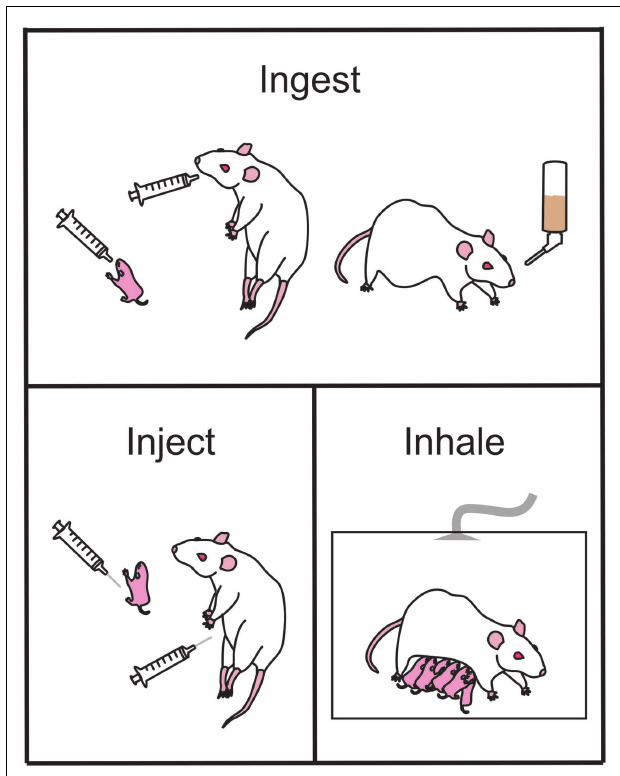
FIGURE 1 | Common ethanol administration techniques in rodents used to examine the effects of prenatal ethanol exposure in offspring . Ethanol may be ingested by the animal via gavage administration during the early postnatal period (upper panel, left-most) or during gestation (upper panel, middle). Alternately, ethanol may be ingested as a liquid diet (upper panel, right-most). Ethanol injections (bottom left panel) can be administered pre- or postnatal for studies of exact timing of ethanol-induced damage. During the early postnatal period of offspring, the dam and litter can be placed in vapor chambers and be exposed to inhaled gaseous ethanol (bottom right